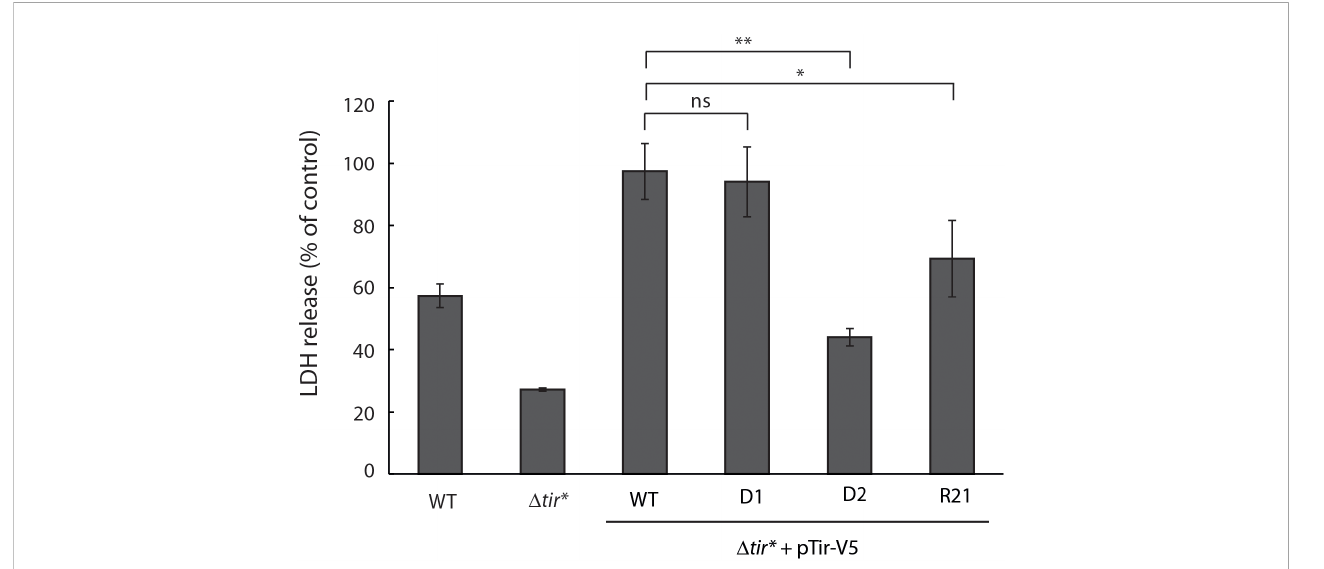
FIGURE 6 Overexpression of Tir increases cellular damage while replacement of TMD1 reduces cellular damage. EPEC WT, D tir *, and EPEC D tir * expressing Tir wt - V5, Tir- D1 -V5, Tir- D2 -V5, or Tir- R21 -V5 variants were grown under T3SS-inducing conditions for 3 h before the infection of HeLa cells for 4 h. The culture supernatants were then collected and analyzed for LDH release. Bars represent geometric means for each strain, tested in quintuplicates over three independent experiments. Error bars represent standard deviation. **, p < 0.01; *, p<0.05, unpaired Student ’ s t-test. ns, not signi fi